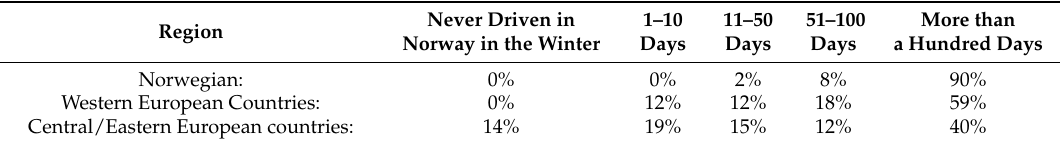
Table 3. National groups’ distributions on the question «Approximately how many days have you been driving on Norwegian winter roads in total» Per cent. Norwegian (N = 61), Western European country (N = 17), Central/Eastern European country (N = 52).